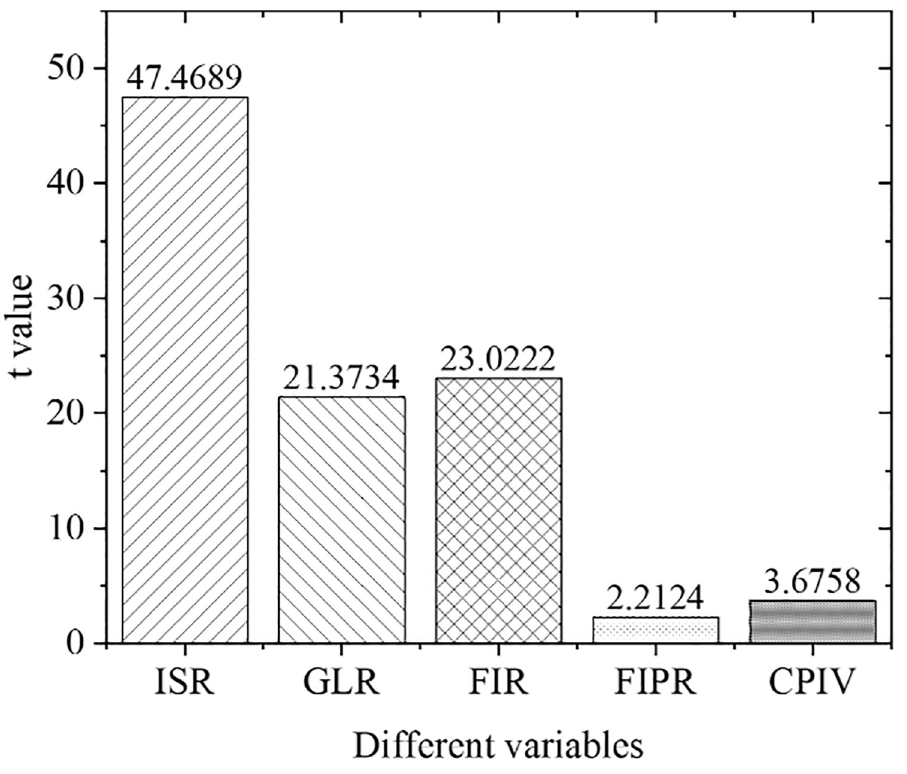
Fig 6. Calculation results of overall t